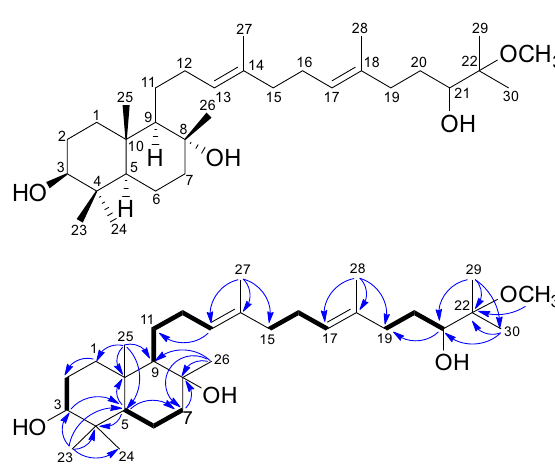
Figure 1: Structure, key 1 H – 1 H COSY ( ▬ ) and HMBC correlations ( H → C ) of compound 1